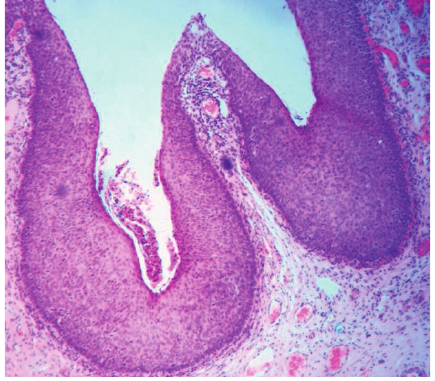
Figure 2: LLETZ with CIN